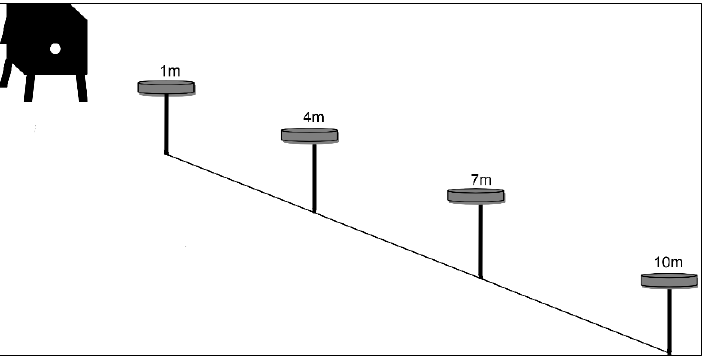
Figure 2. The experimental set-up for Experiment 2 was modified from the method used in Ciar et al. [11]. Four Petri dishes that contained 50% sugar (sucrose) concentrations were placed on the feeder stands at four different distances (one meter, four meters, seven meters, and 10 m) in front of the colony entrance. The grey dot on the beehive represents the entrance of the bee colony. The colony entrance and feeder stands were placed facing east toward the sunrise during the actual experimental trials.